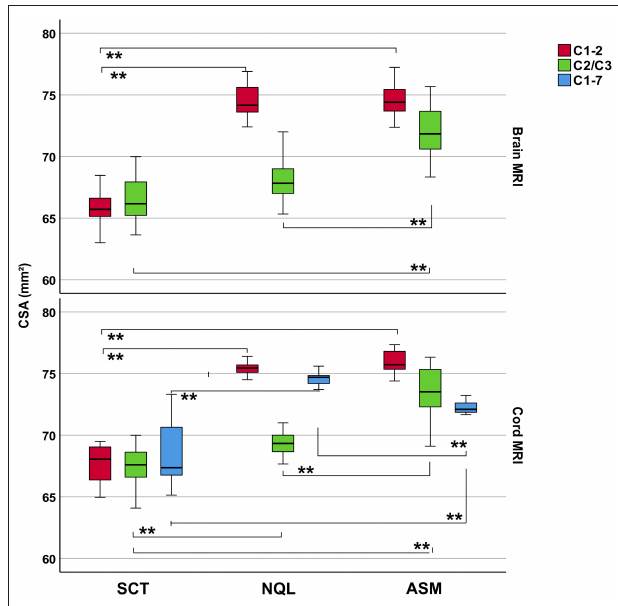
FIGURE 3 | Cross-sectional area (CSA) estimates (pooled across all scanner sites and scan repetitions) differentiated for brain or cord MRI, software methods, and cord vertebral levels. Boxes: median and interquartile range, error bars: 95% interval. Significance between groups: Kruskal–Wallis test. Post-hoc pairwise comparisons including Dunn’s post-hoc test with Bonferroni adjustment for multiple comparisons. ** p < 0.001.